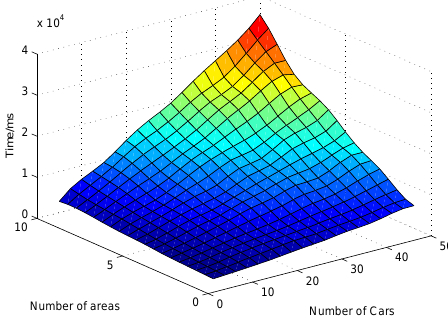
Figure 4. Computational costs on the SP